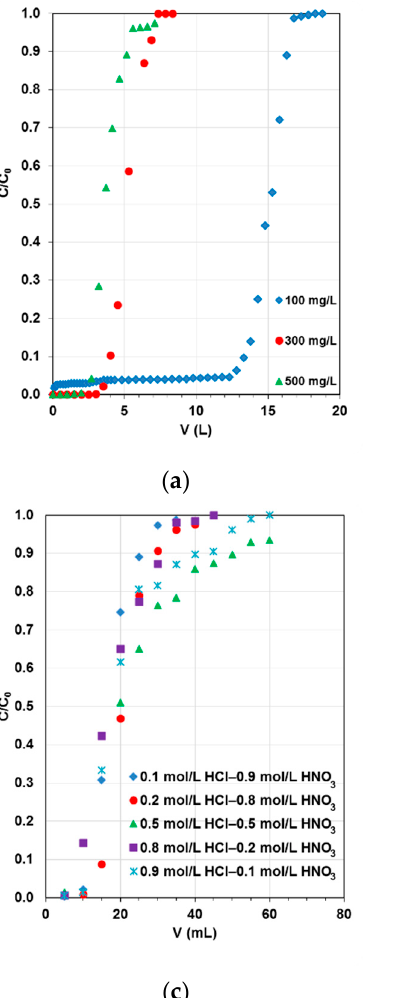
Figure 7. Breakthrough curves for the dye and selected heavy metal ions adsorption on S5528 resin from the systems: ( a ) 100–500 mg/L AG16, ( b ) 100 mg/L Cu(II)–0.1–6 mol/L HCl, ( c ) 100 mg/L Cu(II) –0.1–0.9 mol/L HCl–0.9–0.1 mol/L HNO 3 , ( d ) 100 mg/L Ni(II)–0.1–6 mol/L HCl.